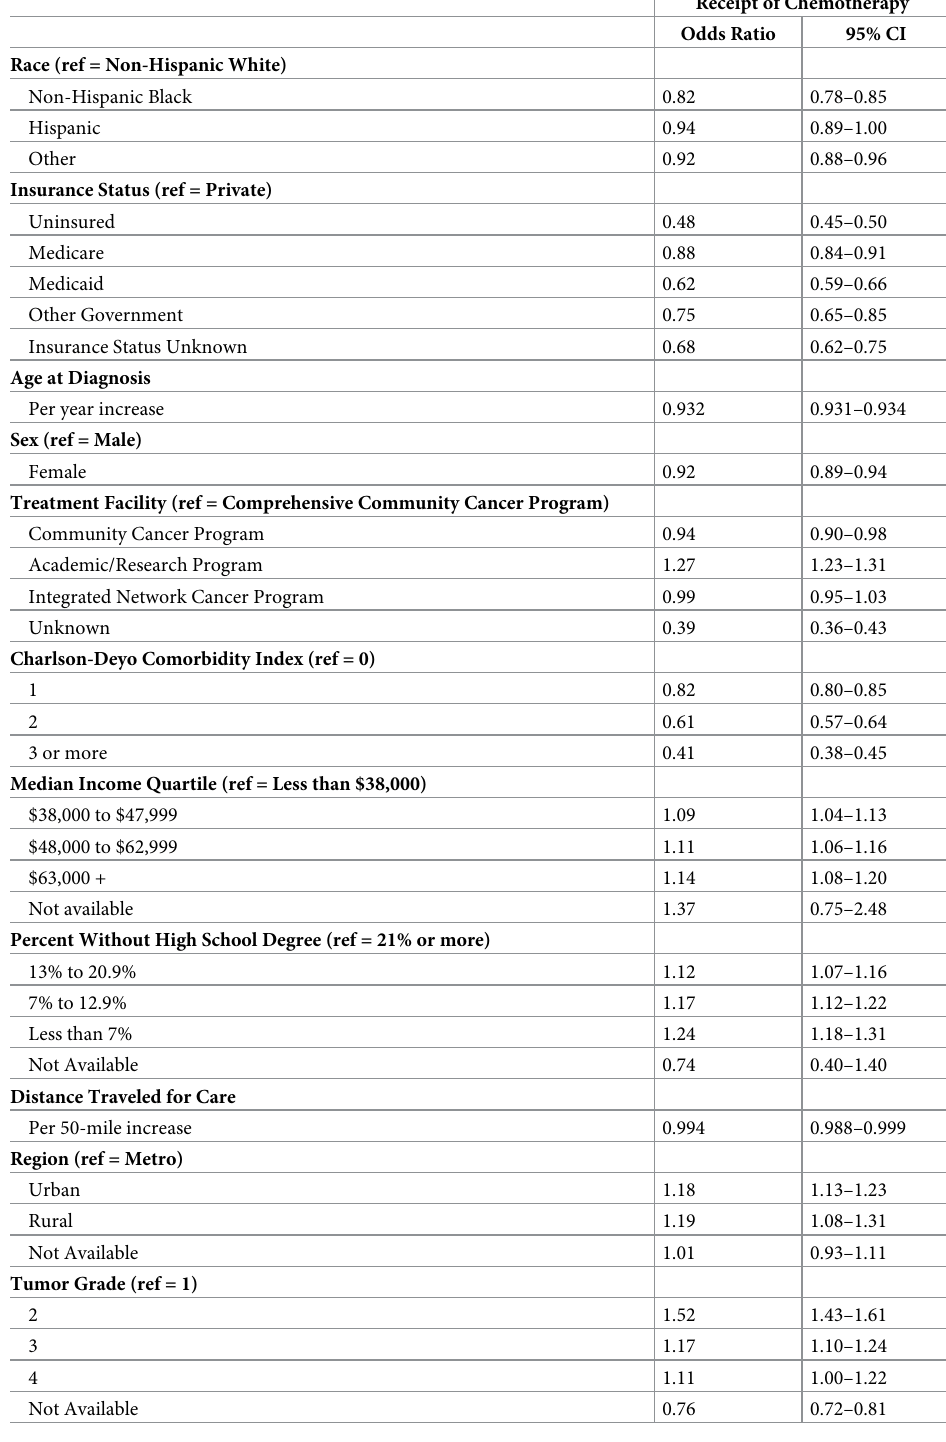
Table 3A. Adjusted odds ratio of receipt of systemic chemotherapy using the main effects additive